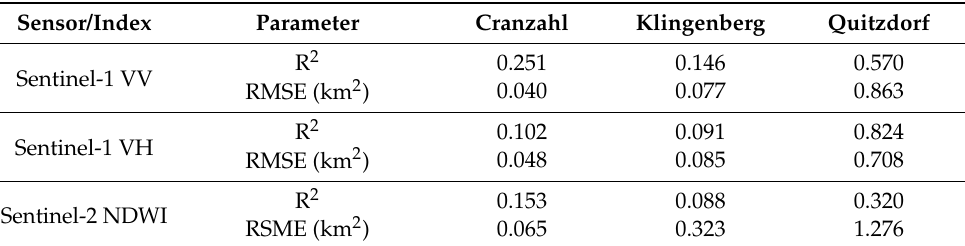
Table 1. Quality parameters of the WMA water area measurements from 1 January 2016 until 31 December 2021 in relation to the in situ